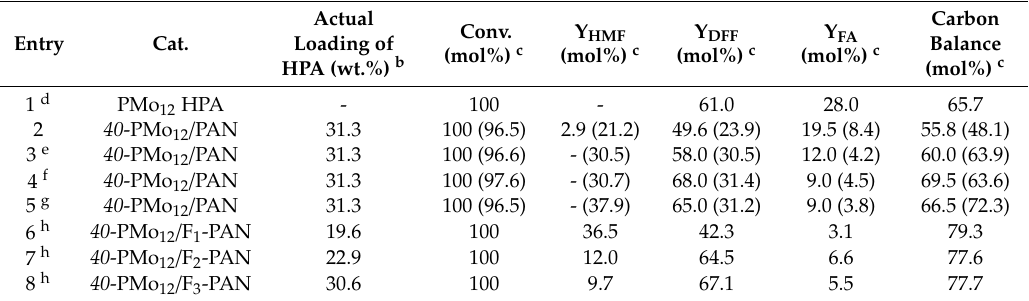
Table 2. Catalytic performance of several catalysts in the “one-pot” and “one-step” conversion of fructose to DFF.